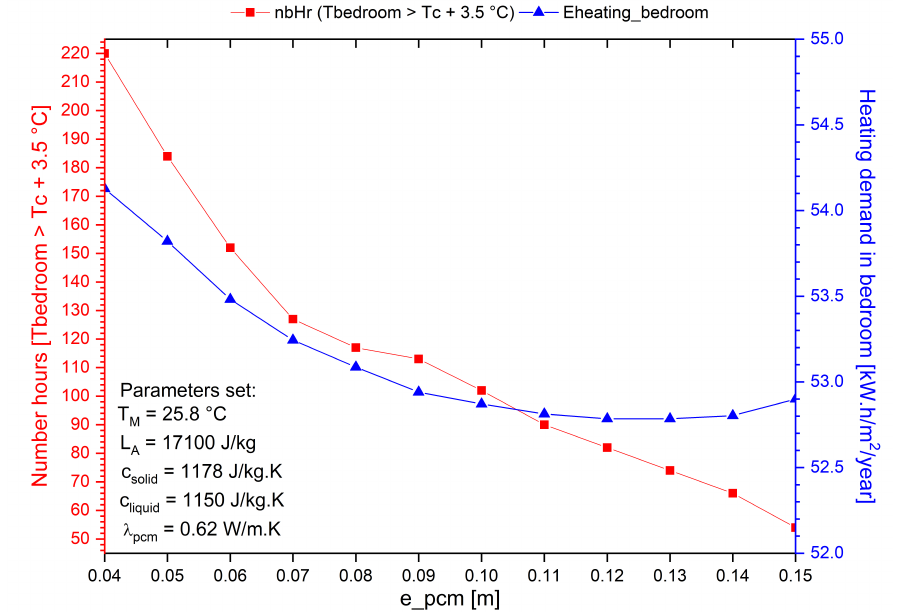
Figure 14. Number of hours of thermal discomfort and heating demand vs. storage wall thickness during the cold season (7 months total: January–April and